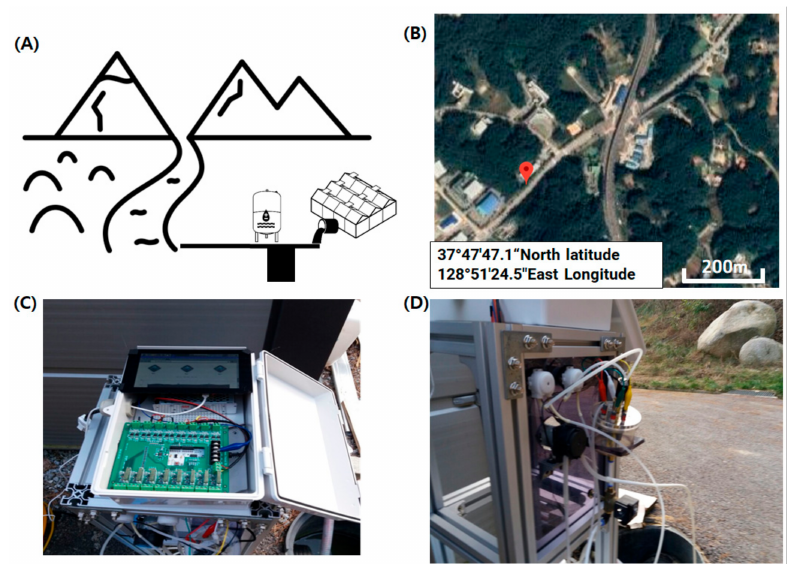
Figure 5. Field-test site and configuration of monitoring equipment: ( A ) schematic diagram of test location; ( B ) satellite image showing location latitude and longitude; ( C ) online stationary monitoring system, and ( D ) array of three nitrate